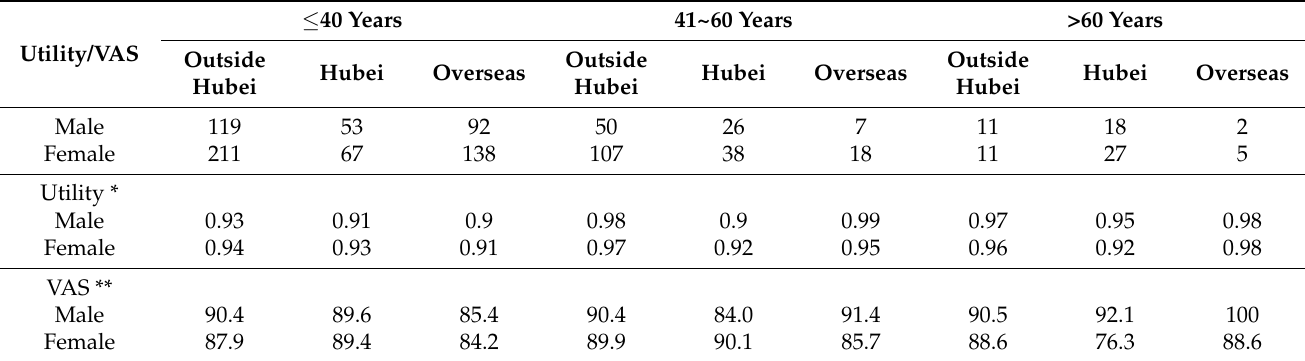
Table 3. Mean EQ-5D-5L utility and visual analogue scale (VAS) scores, by age group, gender, and region. ≤ 40 Years 41~60 Years Utility/VAS